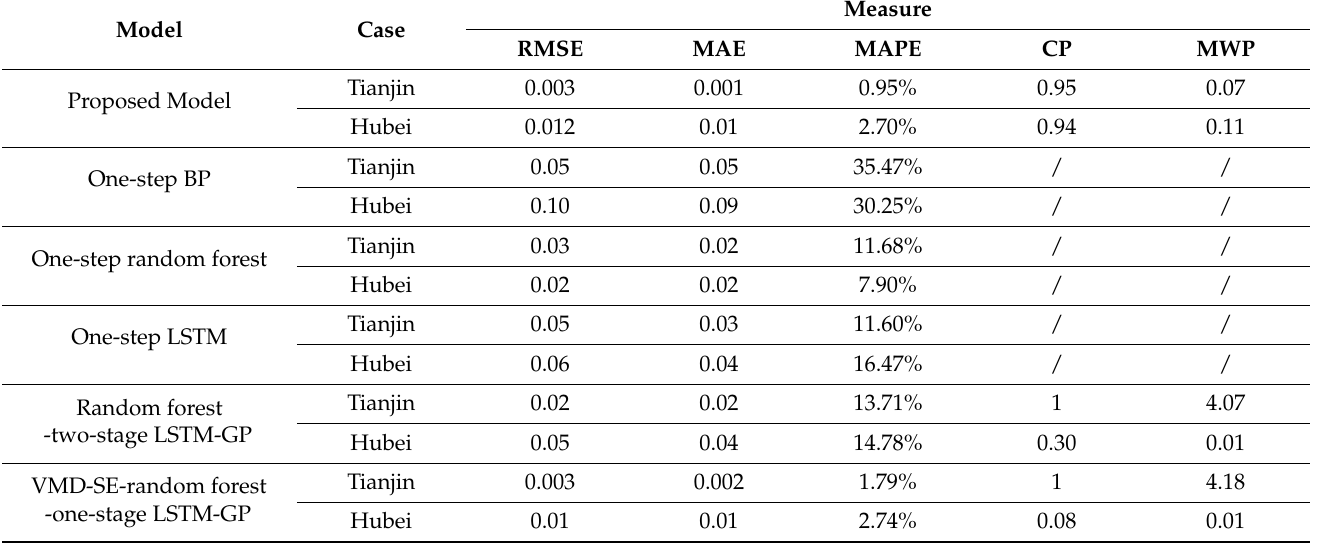
Table 7. Measures of